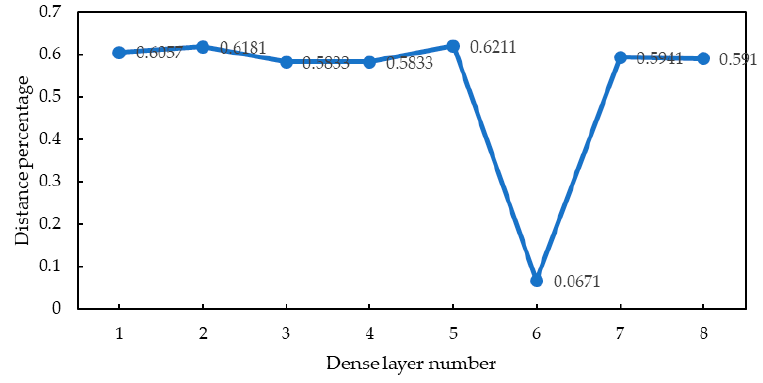
Figure 9. The distance percentage of different LSTM layer number.